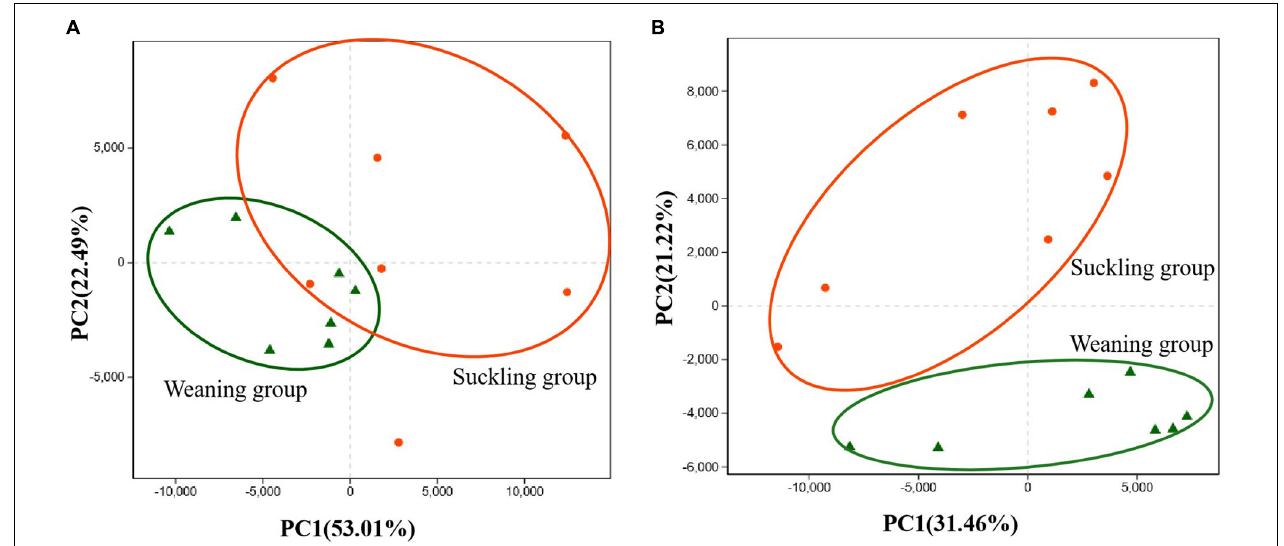
FIGURE 2 | Principal co-ordinates analysis (PCoA) plots. (A) PCoA on phylum level; (B) PCoA on genus level. Adonis test showed weaning has a significant impact on the colonic microbial community ( R 2 = 0.22, P = 0.02 at the phylum level) and ( R 2 = 0.21, P = 0.01 at the genus level). Orange dots represent the suckling piglets, green triangles represent the weaned piglets, N = 7.